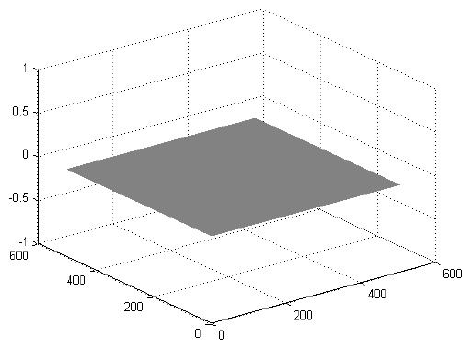
Figure 4. The difference between the recovered complex images of RD-SIM and CI-SIM.